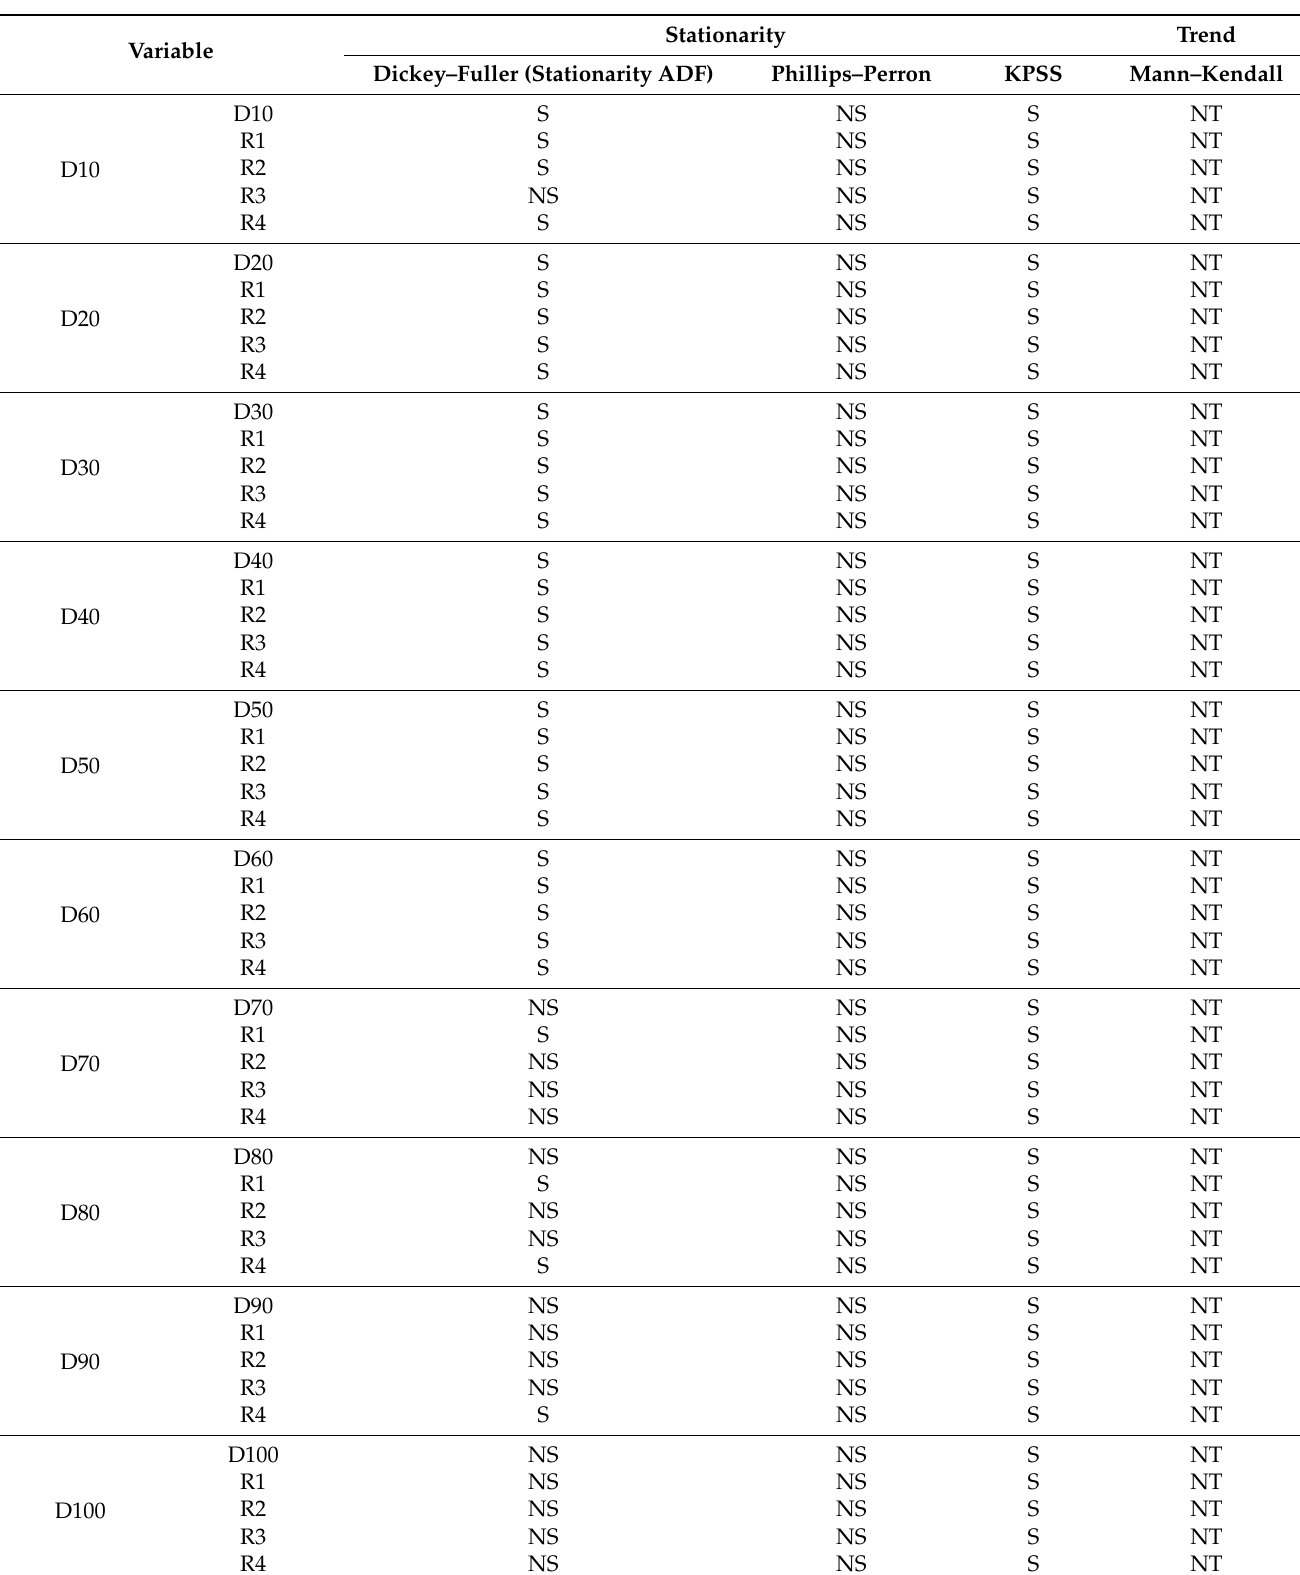
Table A2. Results of the stationarity and trend tests for the original series (D10 to D100) and residuals (R1, R2, R3, and R4),